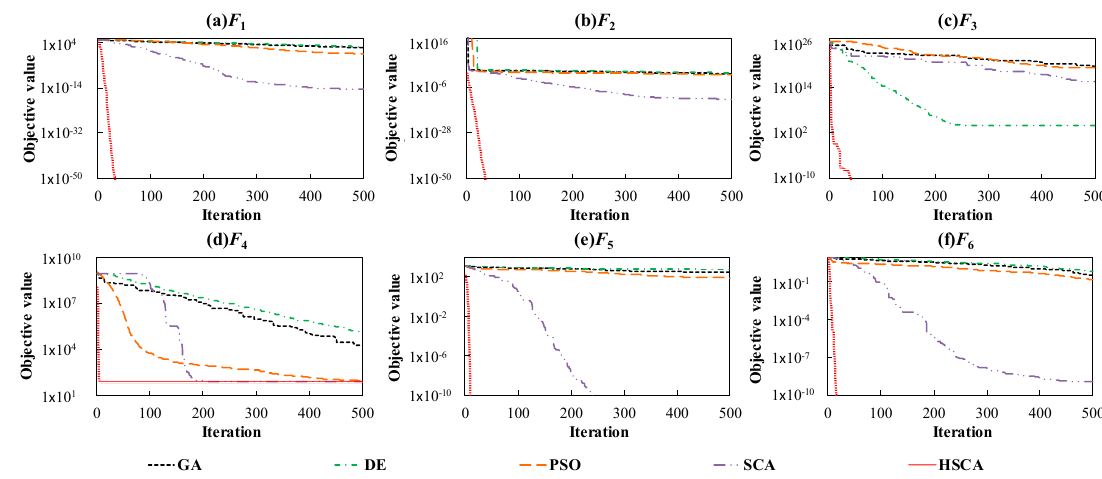
Note: std.=standard deviation (the same below).